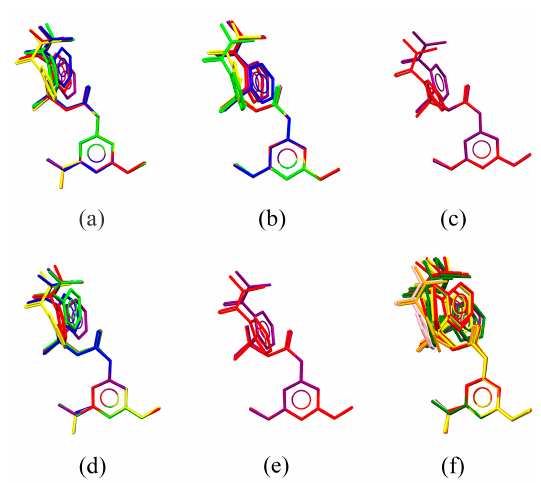
Figure 3. ( a ) 1-D chain formed by the hydrogen bonds along the b axis in NS-MeOH. ( b ) Packing motifs formed by the hydrogen bonds in NS-MeOH.